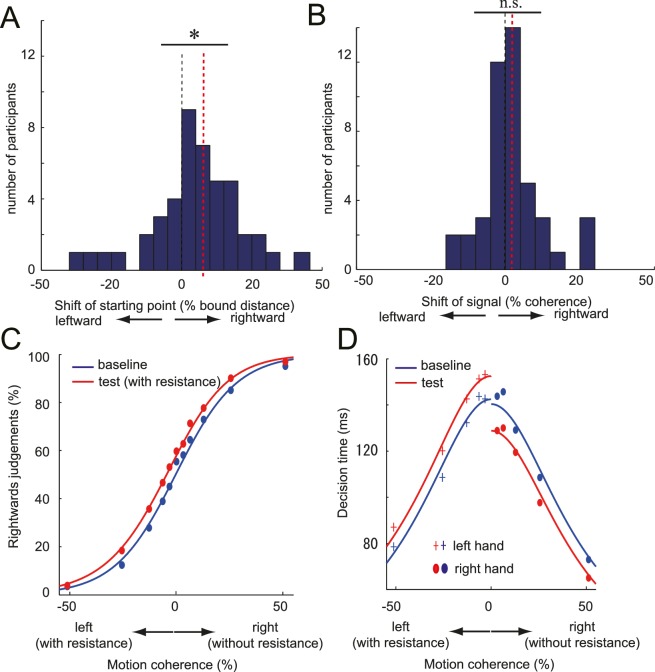
DDM parameter estimates and the fitted psychometric and chronometric function.(A,B) Histogram of individual starting point shift (A) and the evidence accumulation shift (B) calculated from the DDM (full model). Black dotted line indicates the 0% point (i.e. no effect), and the red dotted line indicates the median of the distribution (i.e. amount of shift). Significant rightward shift of the starting point was observed (median: 5.6%), whereas not for the evidence accumulation shift (median: 1.39%). (C, D) Fit of DDM to the choice (C) and the decision time (D) data averaged across participants (see Materials and methods and Figure 4—figure supplement 1 Panel C). Data for Figure 4A–D is available as Figure 4—source data 1. *p<0.05.DOI:
http://dx.doi.org/10.7554/eLife.18422.01110.7554/eLife.18422.012Figure 4—source data 1.Individual starting point shift in the test phase from the baseline phase during the manual trials, estimated from the full-model DDM (summarised in Figure 4A), individual evidence accumulation shift in the test phase from the baseline phase during the manual trials, estimated from the full-model DDM (summarised in Figure 4B), data points consisting the psychometric function estimated from the DDM (starting point model) using the group averaged data (summarised in Figure 4C) and data points consisting the chronometric function estimated from the DDM (starting point model) using the group averaged data (summarised in Figure 4D).